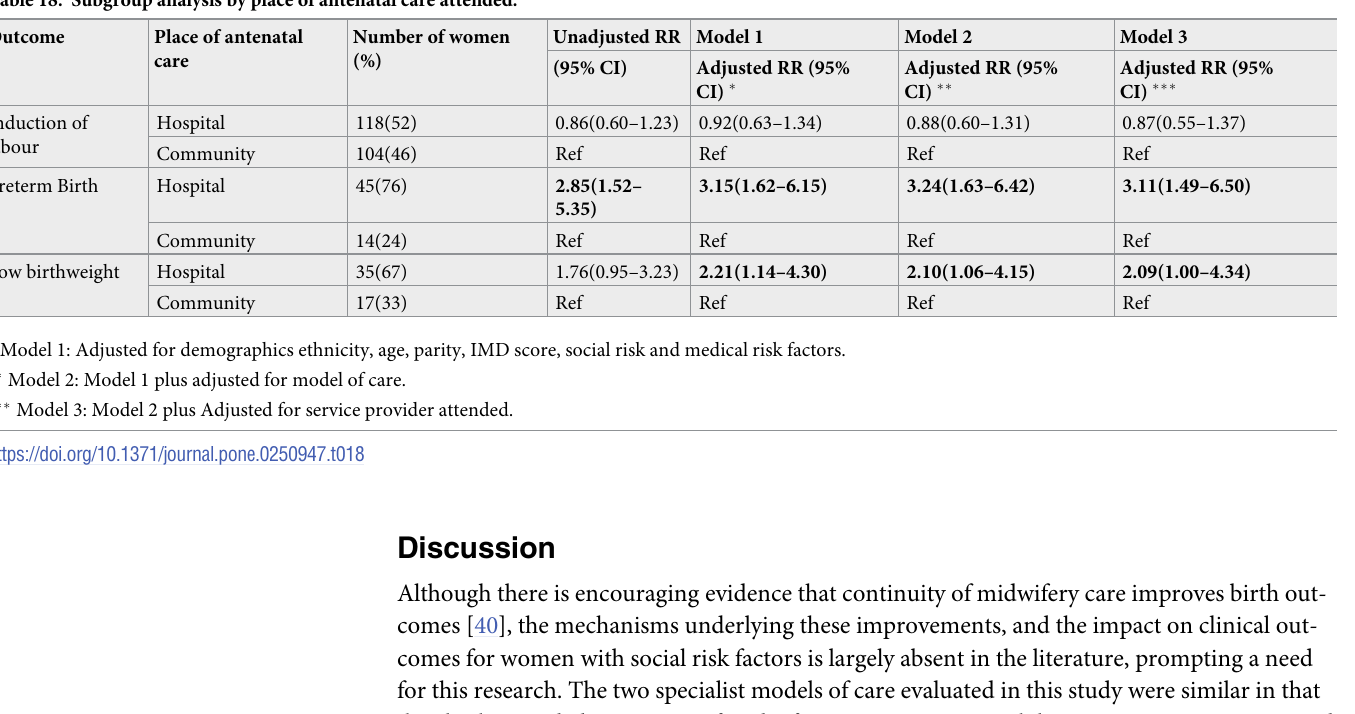
Table 18. Subgroup analysis by place of antenatal care attended.